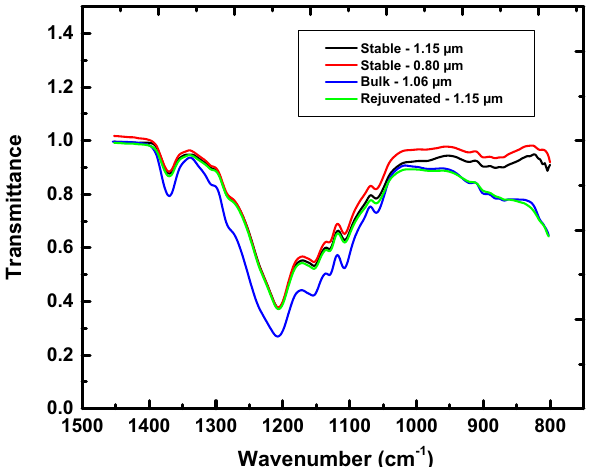
Figure 1. FTIR spectrographs for stable and bulk (virgin) CYTOP films at various thickness, as indicated. Peaks in the range of 1100–1200 cm −1 are due to –CF 2 and peaks in the range of 1340 cm −1 are associated with